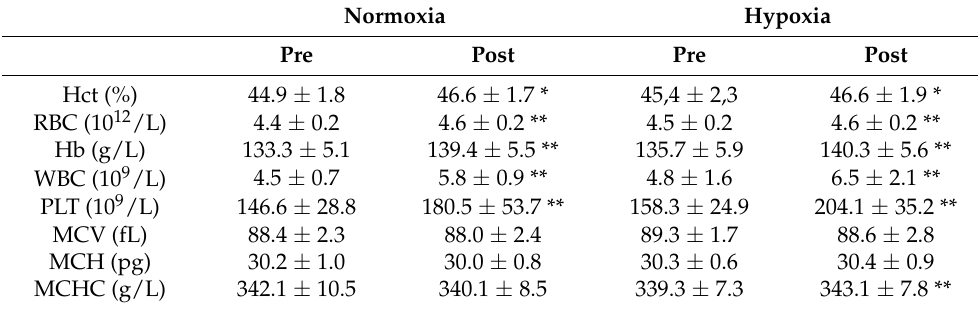
Table 3. Hematological parameters.